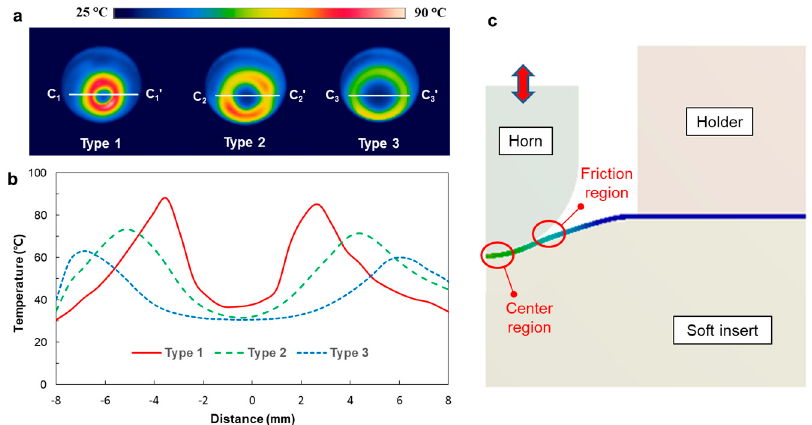
Figure 6. Temperature measurement results after 0.3 s vibration: ( a ) temperature distributions for three horn types; ( b ) comparison of the sectional temperature profiles (Section C i –C i ’ in Figure 6a); ( c ) description of the center region and the friction region.